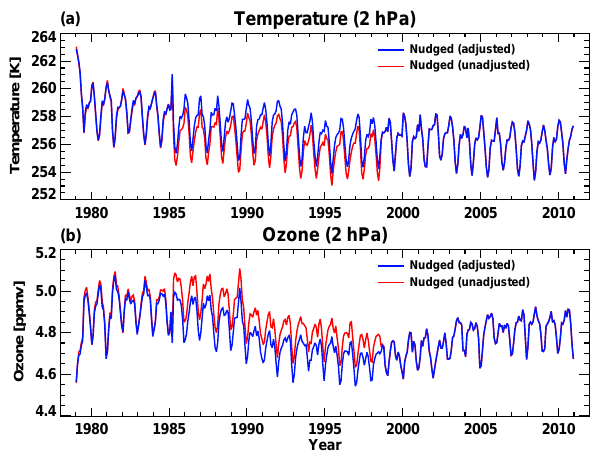
Fig. 8. Same as Fig. 7 but for